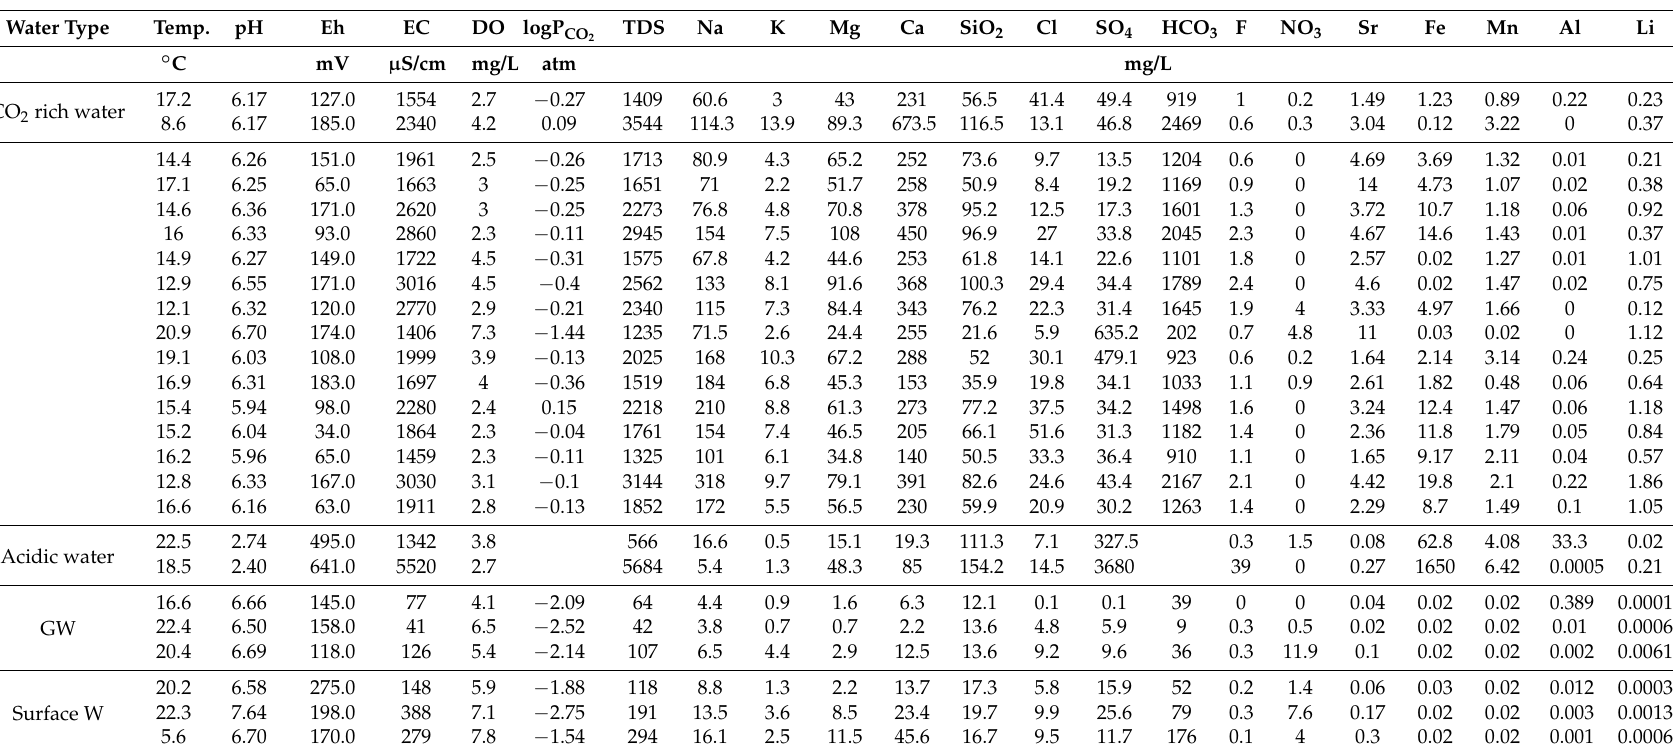
Table 6. Geochemical data of water samples from Gyeongsang Province